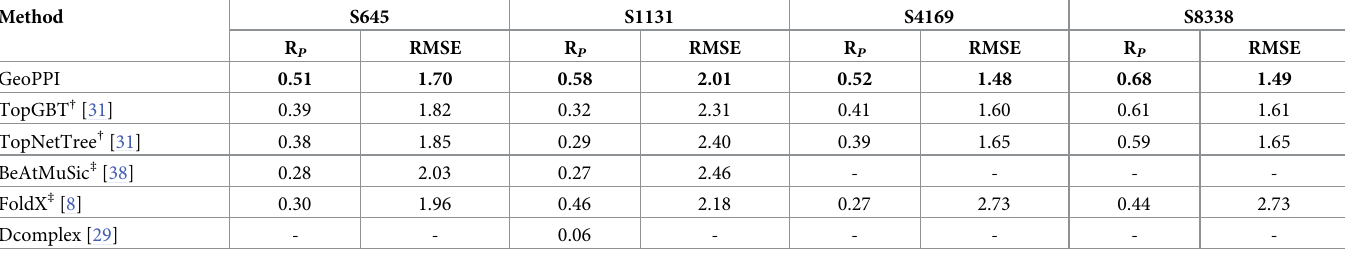
Table 1. Comparison of individual methods for the single-point mutations in terms of Pearson correlation coefficient ( R P ) and root-mean-square error (RMSE) on the S645, S1131, S4169 and S8338 datasets. The methods are evaluated by the split-by-structure cross-validation (SSCV), where ECOD is used in data split to avoid the complexes similar to the training data appearing in the test set. The dash sign indicates the results of the corresponding methods are not available. † : Results were obtained based on the released source code. ‡ : Results were obtained via the released tool.